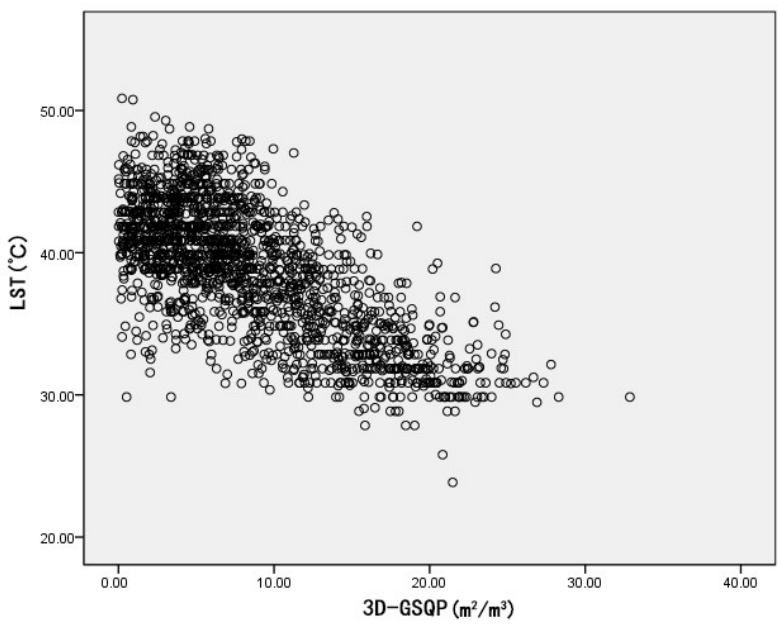
Figure 8. The scatter diagram of 3D-GSQP and LST.